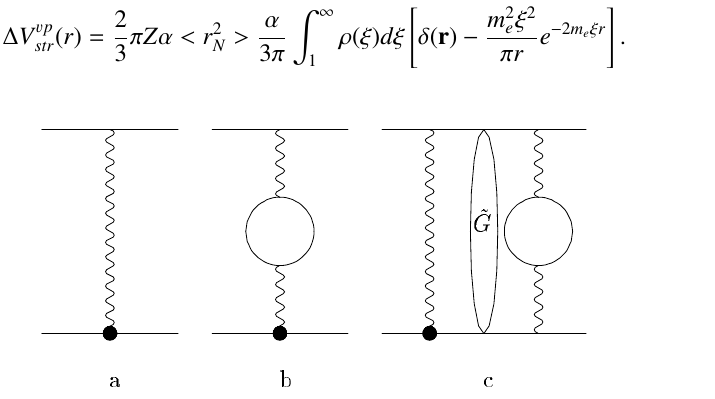
Figure 3. Nuclear structure and one-loop vacuum polarization corrections in first order PT (FOPT) and second order PT